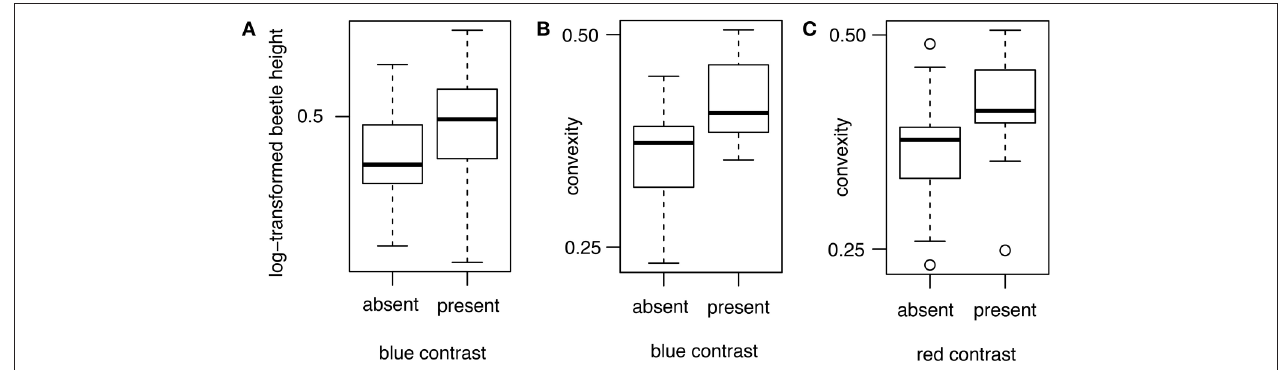
FIGURE 6 | Boxplots illustrating the effect of beetle height on the brightness contrast between beetle and host plant. The x-axis represents the absence or presence of contrast between the beetle and its background. (A) Beetles with greater height tend to have a significant difference in blue contrast with the host plant. Beetles with greater convexity tend to have a significant difference in (B) blue and (C) red contrasts with the host plant.